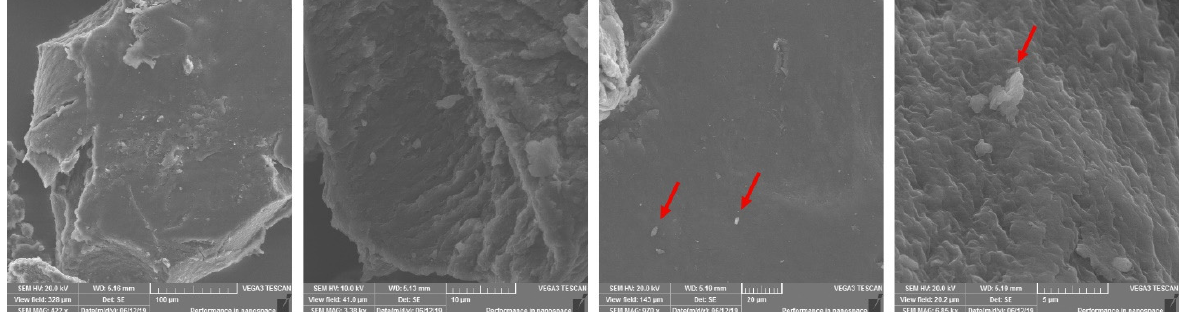
Figure 1. Different magnification SEM images of S. cerevisiae air-dried glucan particles after hot water extraction. Red arrows point to artefacts.